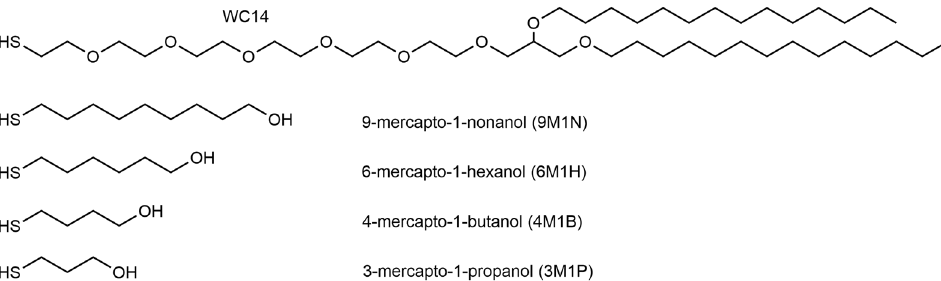
Figure 2. Chemical structure of molecular anchors.